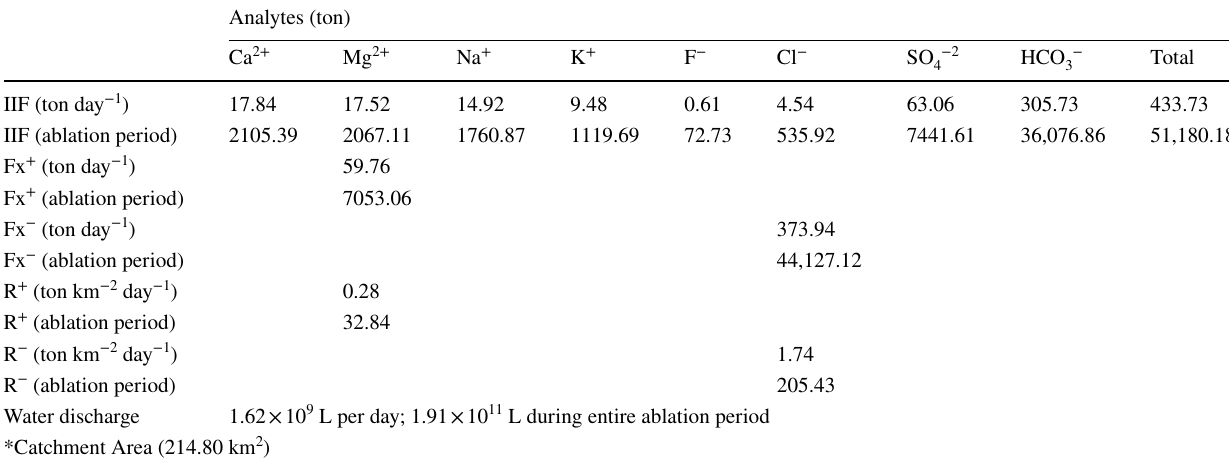
Ablaiton period, 5th June to 30th September (118 days); *Data taken from (Orr et